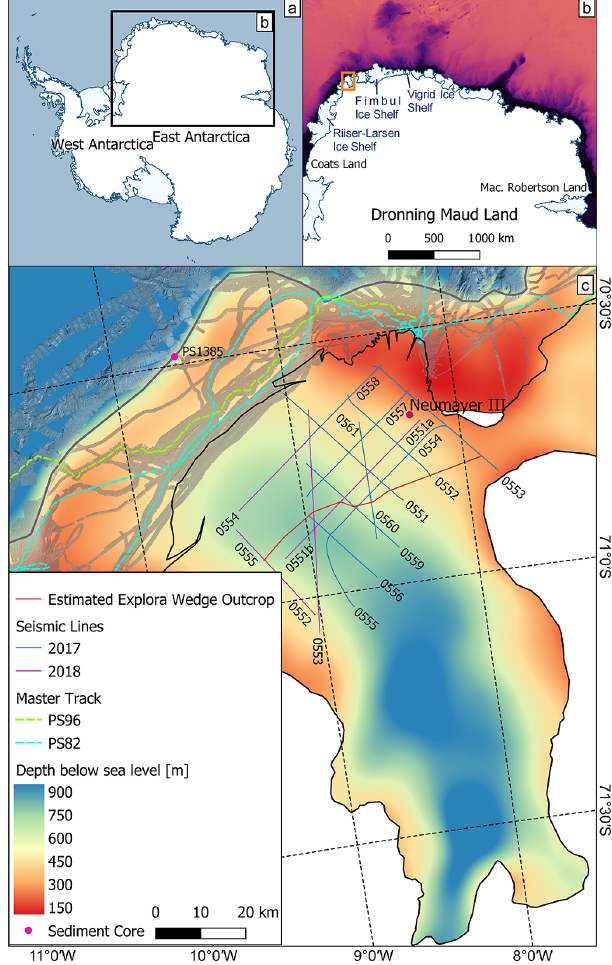
Figure 1. (a) Overview of Antarctica and (b) Dronning Maud Land. The study area is highlighted with an orange box. Panel (c) is a map of the study area in front of and beneath Ekström Ice Shelf. The ice-shelf front (thin black line) is located 25km south of the conti- nental shelf edge (grey line). Ice shelf: sea floor depth is from Eis- ermann et al. (2020), seismic lines used in this study are indicated by the purple and blue lines, and the line numbers are indicated. The outcrop of the volcanic Explora Wedge (Kristoffersen et al., 2014) at the sea floor is shown as a red line and is based on an in- terpretation of the seismic profiles detailed here. In front of the ice shelf: colour-coded high-resolution swath bathymetry data give the sea floor depth. Parasound-tracking lines from Knust (2014) and Schröder (2016) are shown as light blue and green dashed lines. The pink dot on the continental shelf edge (grey line) shows the lo- cation where Grobe and Mackensen (1992) sampled sediment core